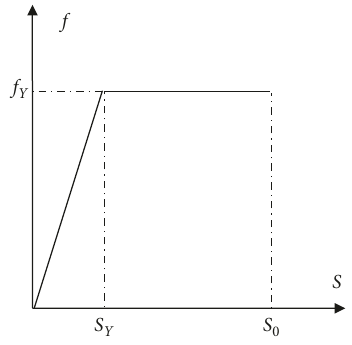
Figure 2: Microplastic material